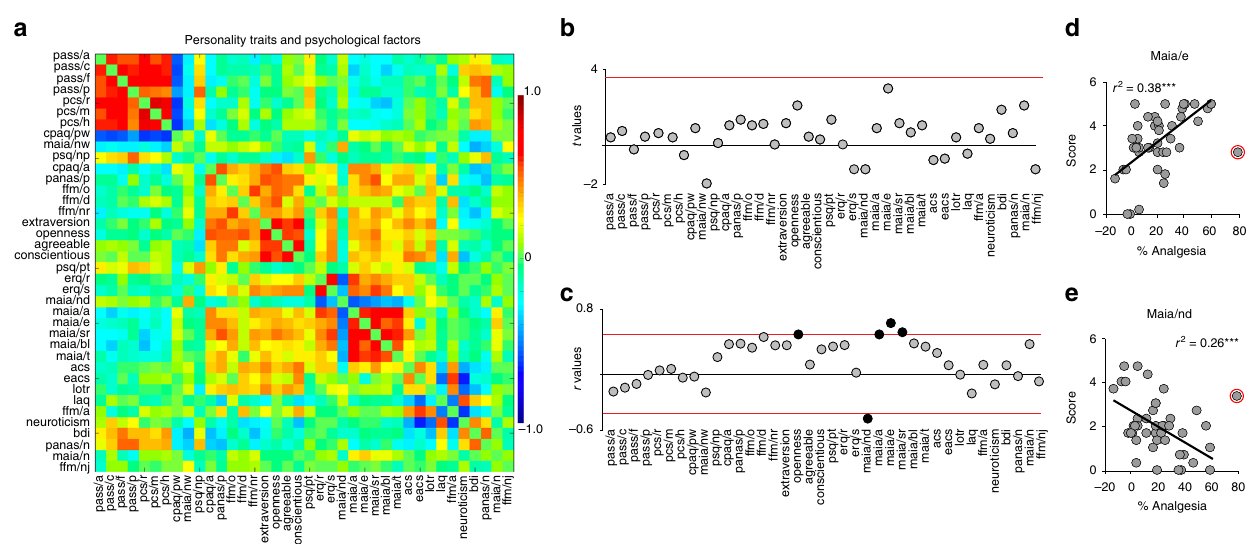
Fig. 2 Personality traits and psychological factors were strongly linked to the magnitude of response. a The covariance matrix shows the relationship between each subscale in the questionnaire data described in detail in Supplementary Table 4. b Univariate statistics showed no group differences surviving Bonferroni correction for 37 comparisons. c However, openness (from the big 5 personality dimensions) and 4 out of 8 subscales from the Multidimensional Assessment of Interoceptive Awareness (MAIA)- Not Distracting (maia/nd), Attention Regulation (maia/a), Emotional Awareness (maia/e), and Self-Regulation (maia/sr)- correlated with the magnitude of response after correcting for multiple comparisons ( p < 0.0013; shown in black). Patients with increased emotional awareness experience greater placebo analgesia (Maia/e displayed in d ), whereas patients who tend not to ignore or distract themselves from discomfort experience less placebo analgesia (Mais/nd displayed in e ). The red circle marks an outlier on the magnitude of response that was excluded. Other abbreviations used: Pain Anxiety Symptoms Scale (PASS) and its 4 subscales — Avoidance (pass/a), Cognitive (pass/c), Fear (pass/f), and Physiological (pass/p); Pain Catastrophizing Scale (PCS) and its 3 subscales — Rumination (pcs/r), Magni fi cation (pcs/m), and Helplessness (pcs/h); Chronic Pain Acceptance Questionnaire (CPAQ) and its 2 subscores — Activity Engagement (cpaq/a) and Pain Willingness (cpaq/ pw); the remaining 4 MAIA subscales — Noticing (maia/n); Not Worrying (maia/nw); Body Listening (maia/bl); and Trusting (maia/t); Pain Sensitivity Questionnaire (PSQ) and its 2 subscales — Painful (psq/p) and Non-Painful (psq/np); Positive and Negative Affect Scale (PANAS) with Positive (panas/p) and Negative (panas/n) subscales; Five Facets of Mindfulness (FFM) with its 5 subscales — Observe (ffm/o), Describe (ffm/d), Act with Awareness